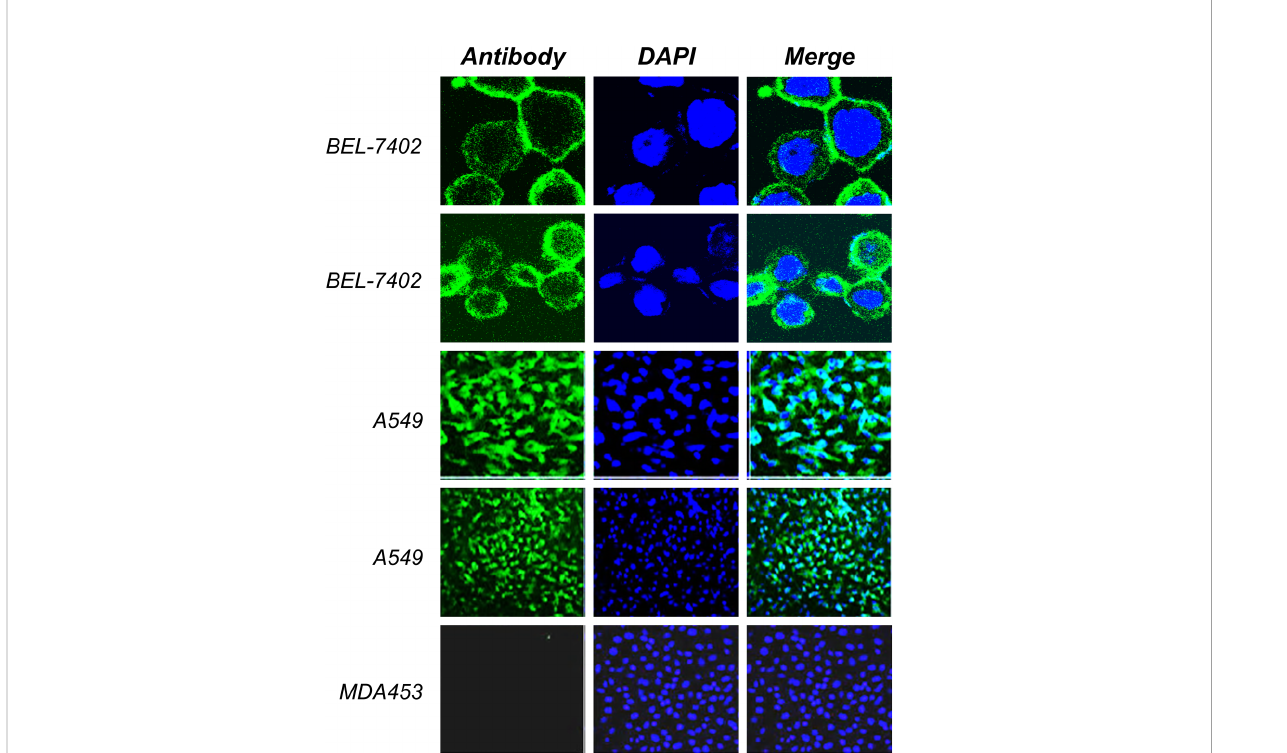
FIGURE 6 Immuno fl uorescence analysis. The positive cell lines (A549, BEL-7402) and negative MDA453 cells were cultured and fi xed on the cover glass. The cultural supernatant was used as the primary antibody and rabbit anti-human FITC conjugated antibody was used as the secondary antibody. Results indicated a high binding af fi nity with positive cells and no such binding was observed in negative cells. DAPI was used for visualization of the